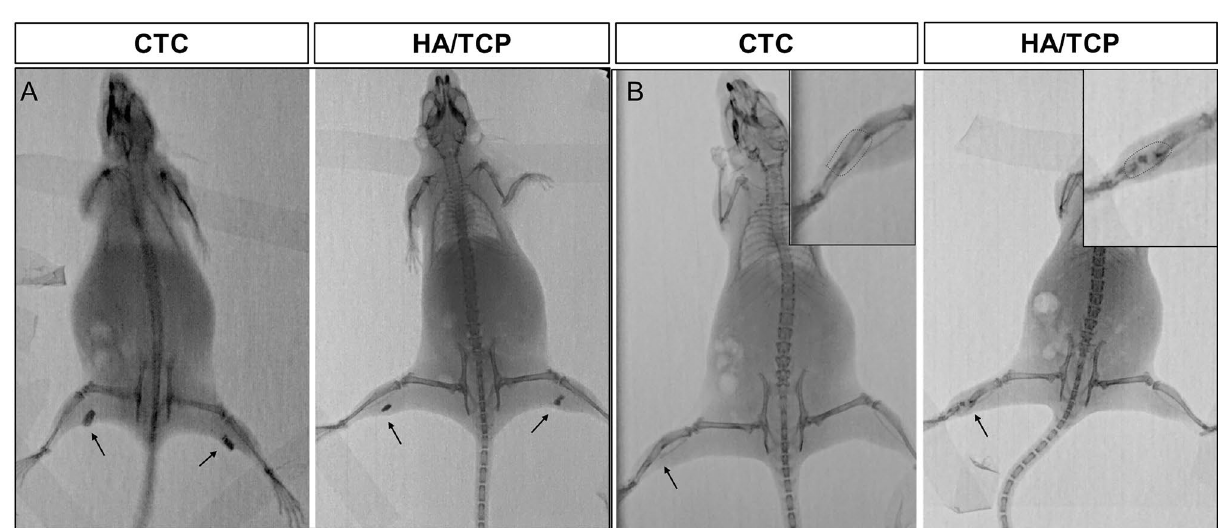
Figure 5. Detection of materials with radiography in vivo. ( A ) The X-ray photography of the CTC and HA/ TCP biomaterials implanted in muscles of bilateral thighs in mice; arrow: the implanted materials. ( B ) The X-ray photography of the CTC and HA/TCP biomaterials filled in the right tibia defects in mice; arrow: bone defect sites; red dotted box: implanted material